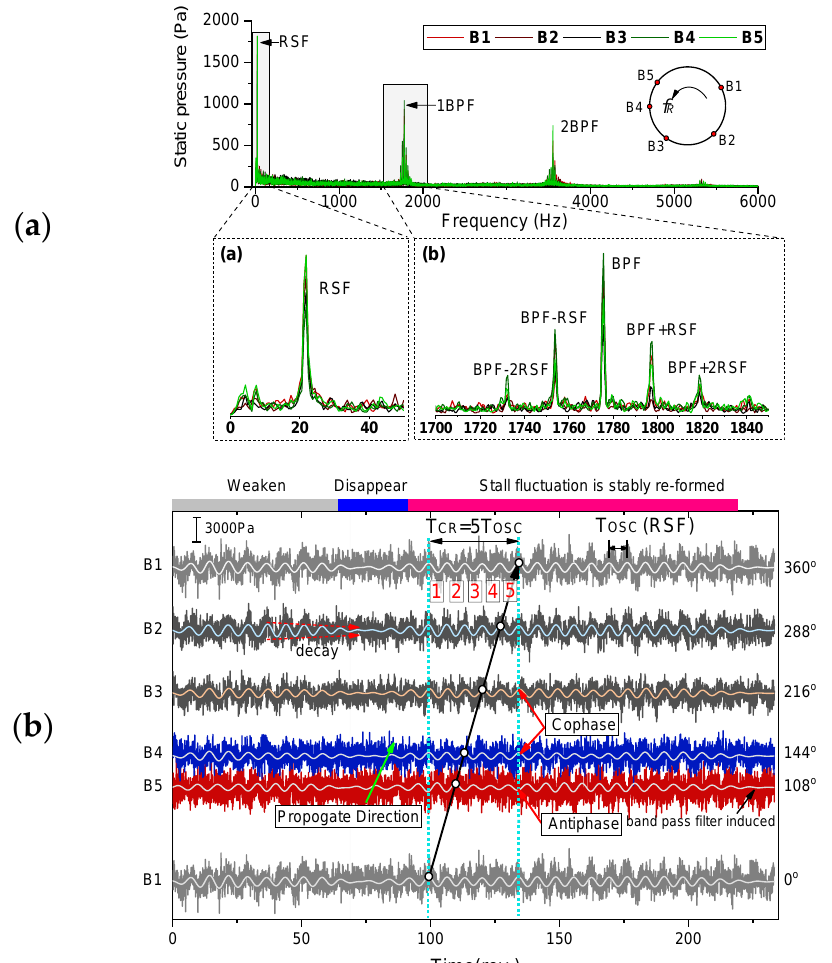
Figure 9. Rotating stall identification and parameter characterization. ( a ) FFT spectrum of diffuser inlet pressure signal; ( b ) spatial pressure distribution at stalled condition.